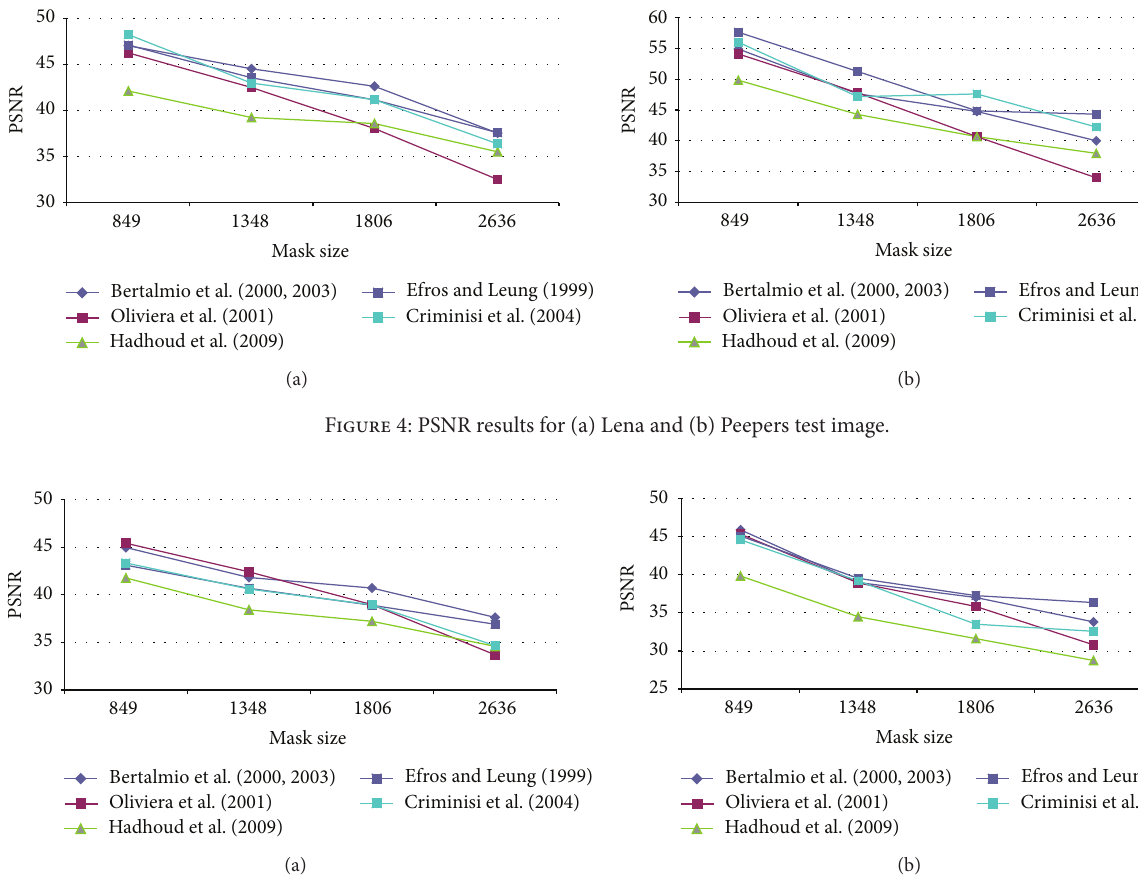
Figure 5: PSNR results for (a) Baboon and (b) StillLifeWithApples test